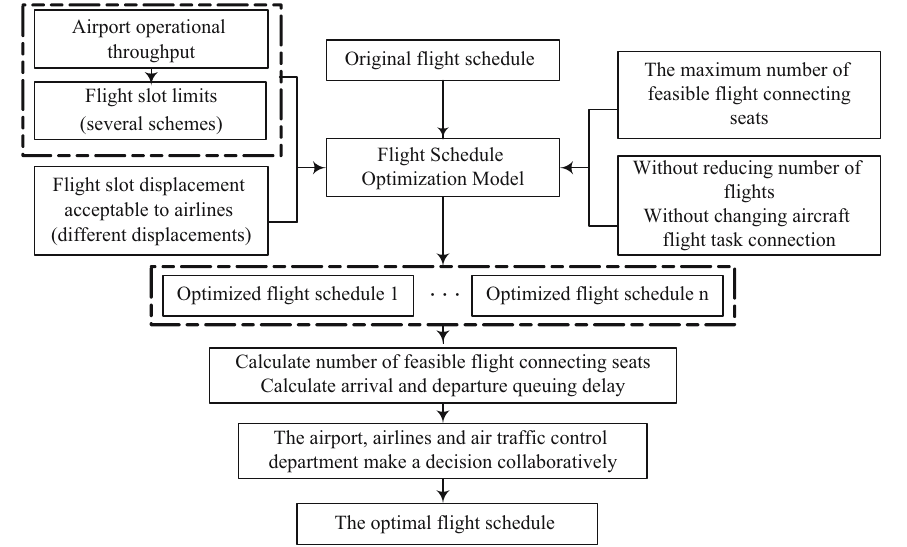
Figure 3: Flight schedule optimization